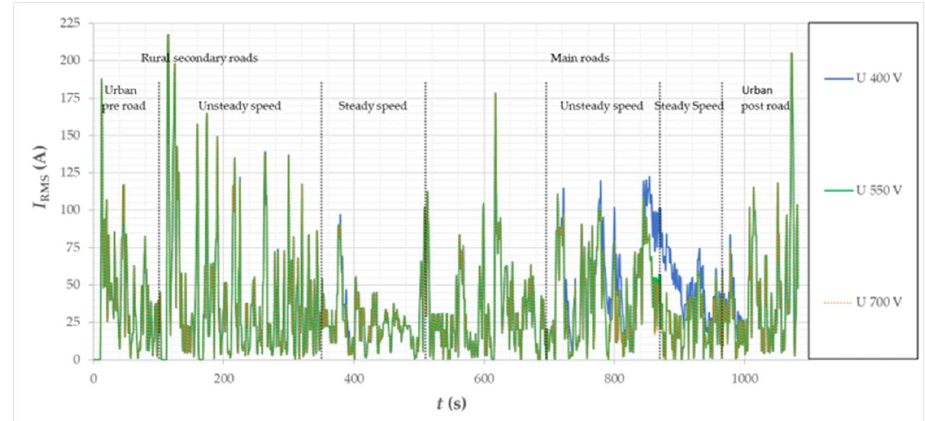
Figure 23. Calculated I RMS supply current waveforms of the motor for the considered vehicle in the Artemis Road driving cycle.